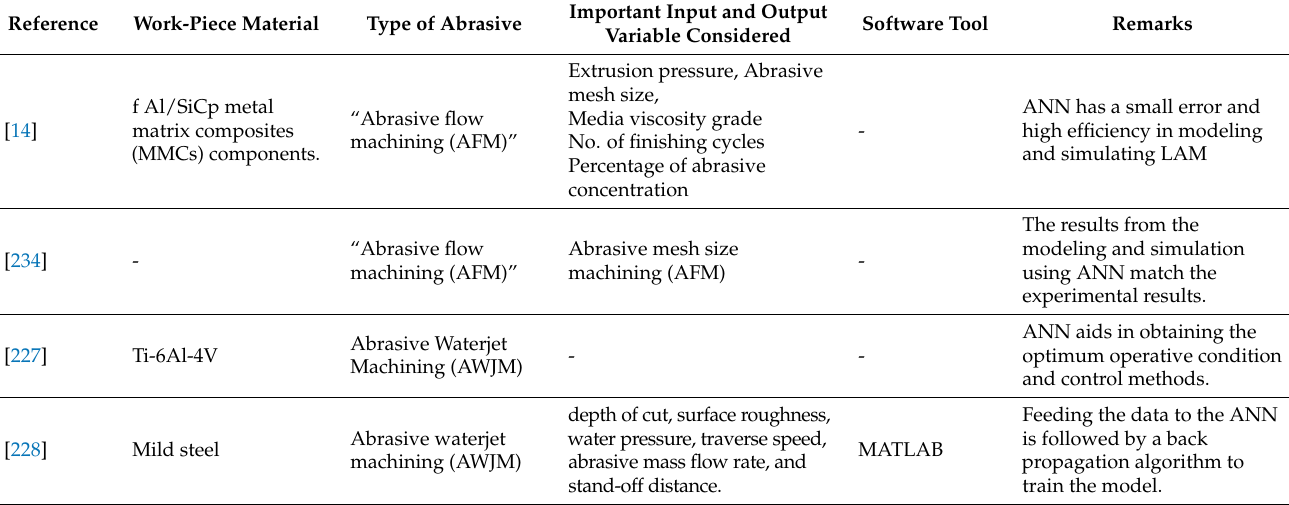
Table 11. Summary table of ANN-based modeling and simulation of the loose abrasive-based